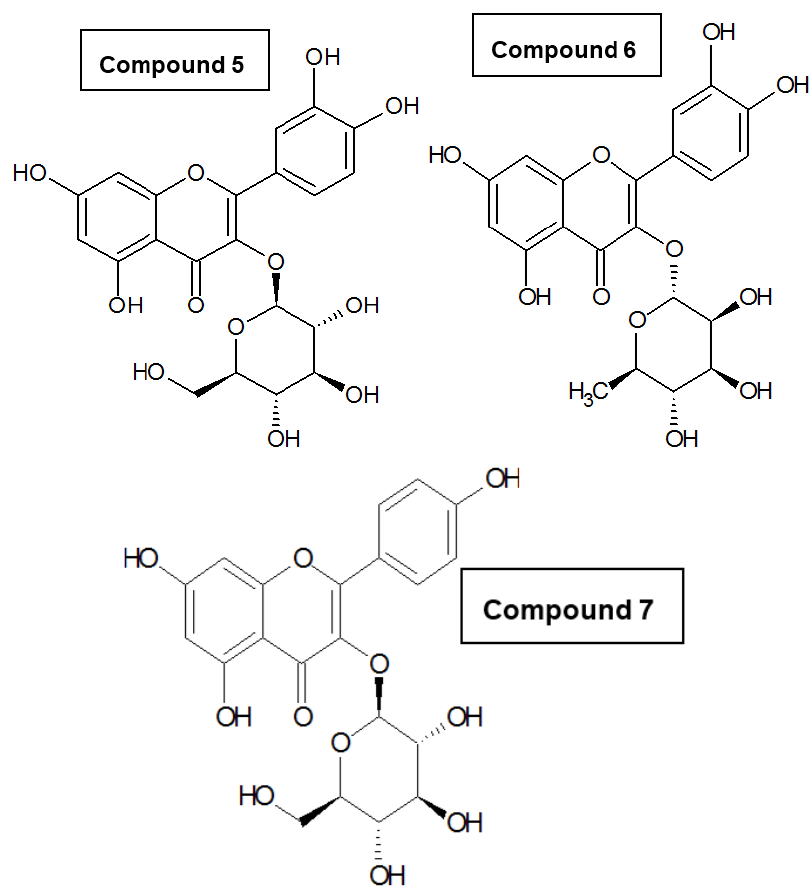
Figure 4. Structures for isolated compounds ( 1–7 ). Table 3. DPPH radical scavenging activity (IC 50 , µg/mL) of different fractions of Z. oxyphylla and C. serrata. n -Hexane